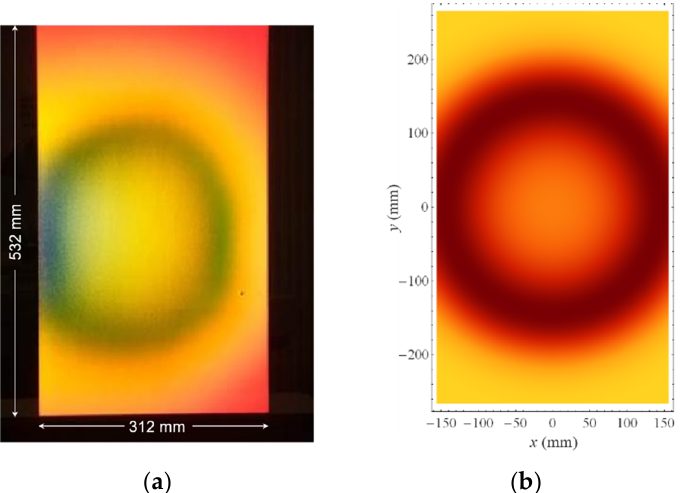
Figure 19. ( a ) diffraction efficiency for the P-HOE reconstructed with slightly divergent white light source. ( b ) model predictions. A 10 mm thick float glass plate was used for the recording element. Using a 19 mm thick float glass plate for the P-HOE recording and also a lower